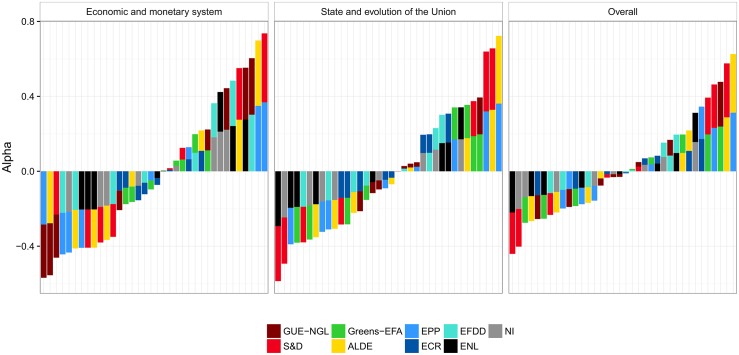
Coalitions between political groups in terms of RCVs as measured by Krippendorff’s Alpha.For nine groups, there are 36 pairs for which we measure their (dis)agreement. Positive values of Alpha indicate co-voting agreement, negative values correspond to systematic disagreement, while Alpha = 0 indicates co-voting by chance. The average Alpha across all 36 pairs is 0.02, close to co-voting by chance. Note, however, that Alpha considers just yes/no votes, and ignores abstentions.